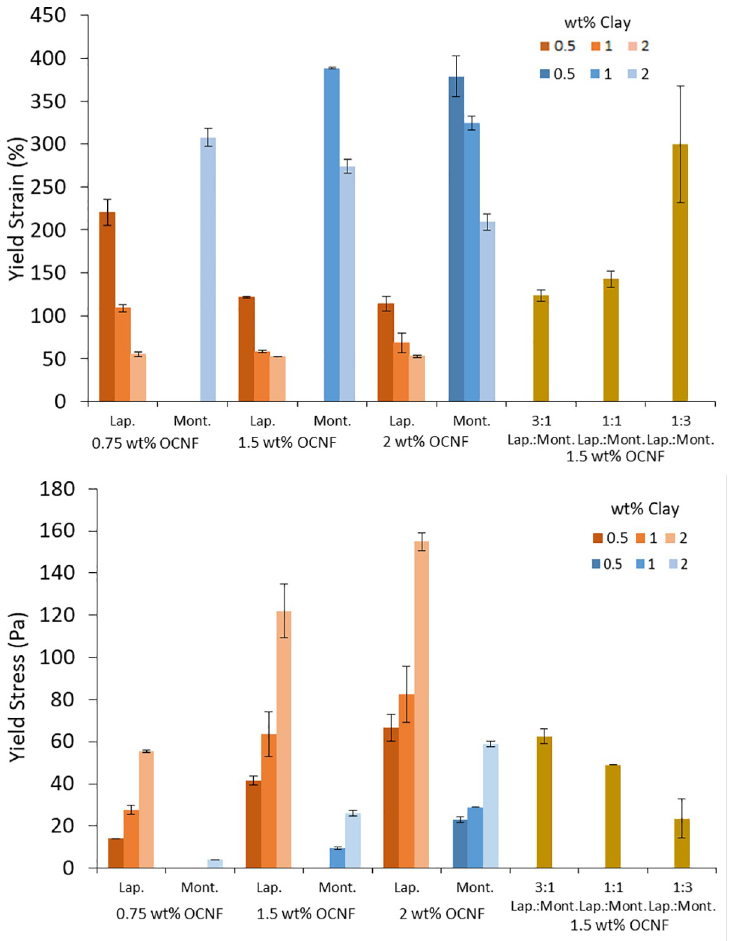
Fig 5. Yield strains (top) and yield stresses (bottom) of mixtures of Laponite and montmorillonite with OCNF, taken from the amplitude sweep curves (see Supporting